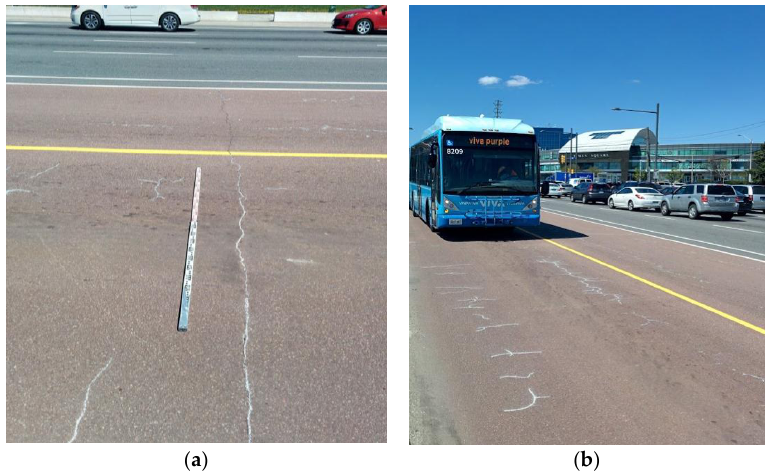
Figure 10. Early signs of cracks observed in sections paved with the Initial Red mixture after few years of in-service: ( a ) premature thermal cracking; ( b ) wheelpath fatigue cracking. The white colour of cracks is because of a chalk used for mapping.